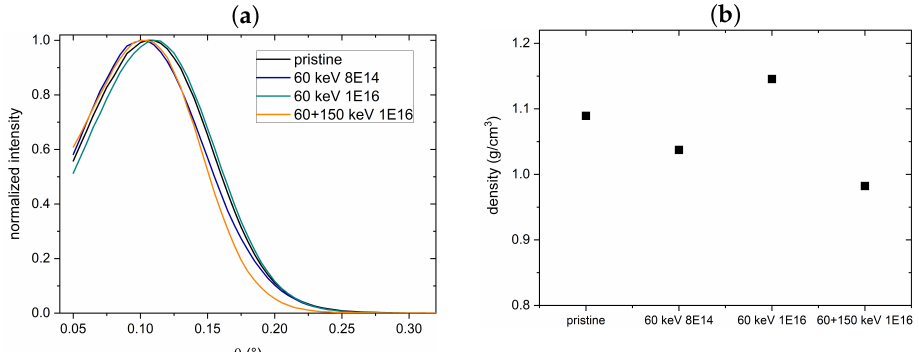
Figure 8. ( a ) Normalized XRR spectra of NT arrays, before and after C bombardment. ( b ) Mass densities obtained from the spectra in ( a ). The standard deviations of the fitted mass densities are lower than